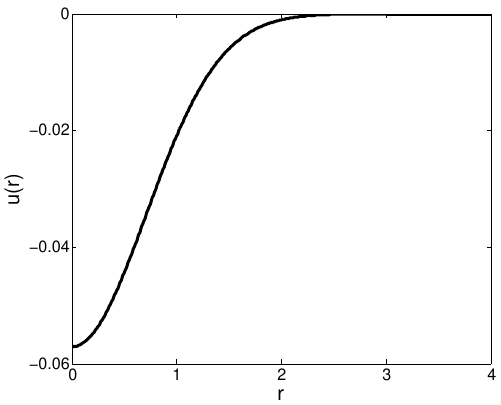
Figure 1 . The interaction potential of the Schwarzschild-AdS black